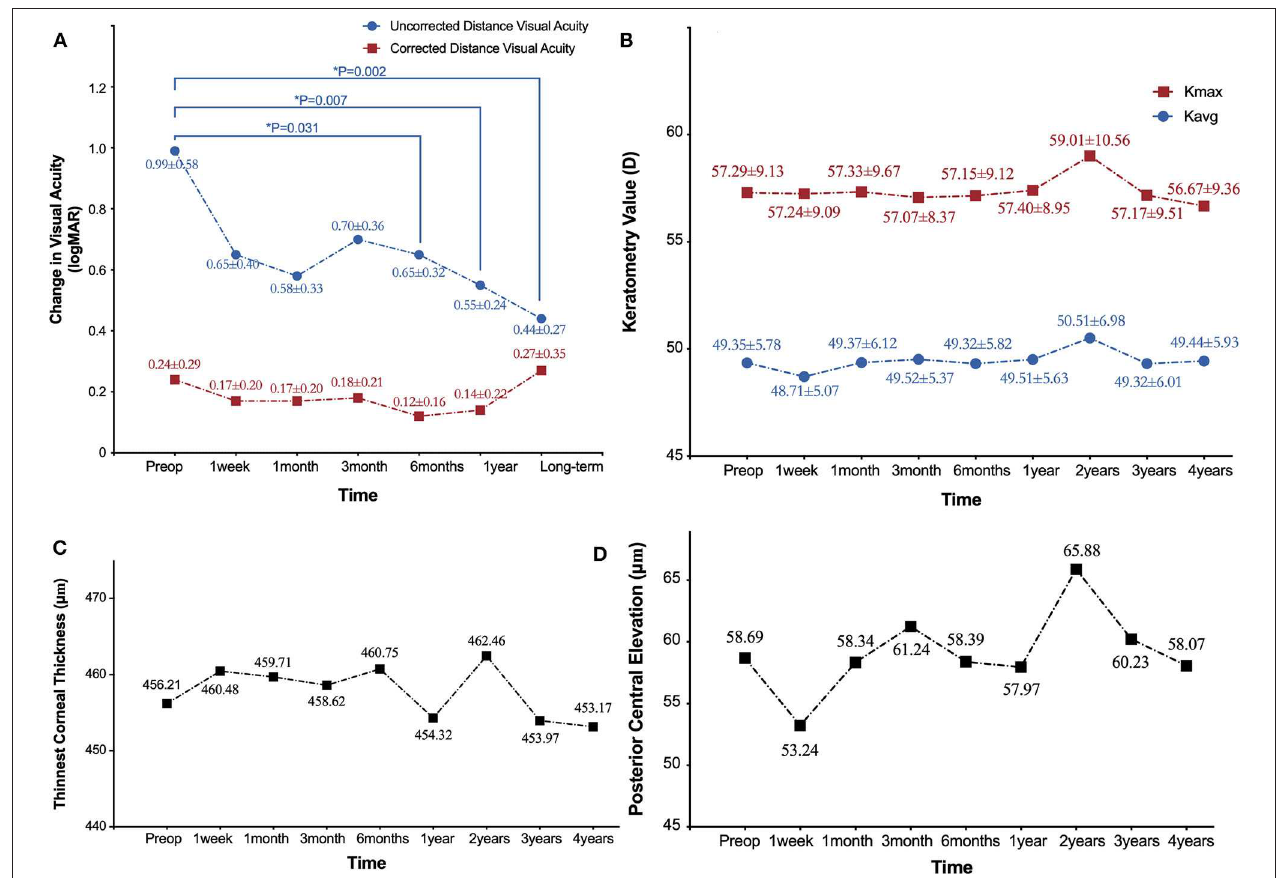
FIGURE 1 | Refractive and topographical outcomes 4 years after ATE-CXL treatment. (A) Time course of change in visual acuity (logMAR). (B) Time course of change in average keratometry values ( K avg) and maximum keratometry values (Kmax). (C) Time course of change in thinnest corneal thickness ( µ m). (D) Time course of change in posterior central elevation ( µ m).*indicates statistically significant difference from pre-operative